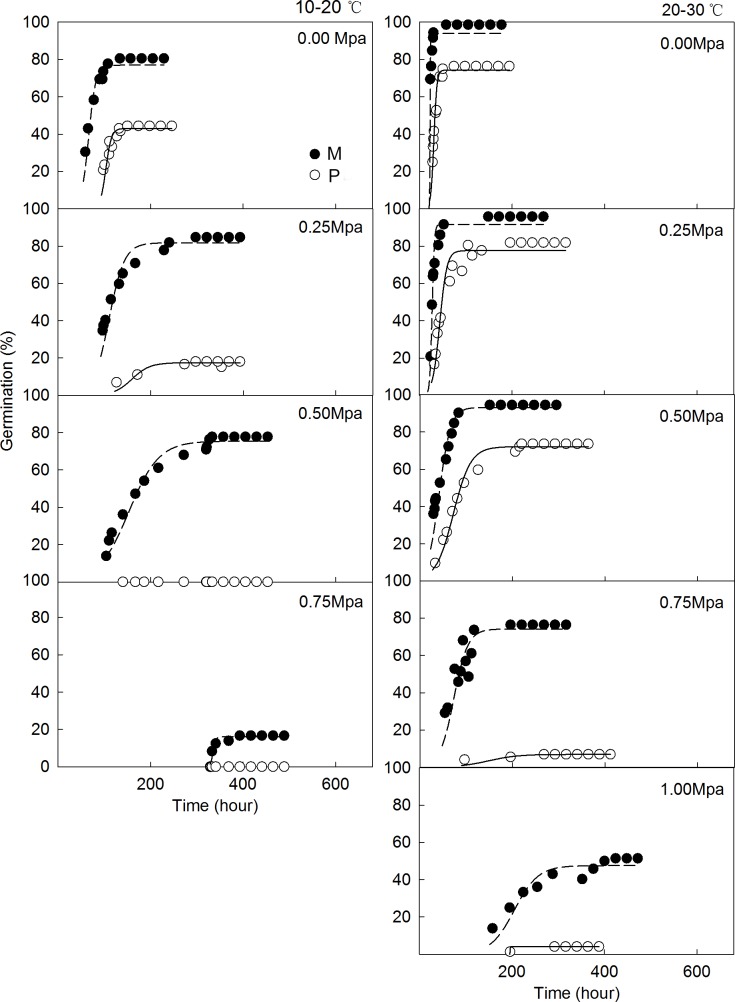
Cumulative M (solid dot) and P seeds (hollow dot) germination time-courses of C. pauciflorus under two temperatures and six osmotic potential regimes.Different symbols represent the observed germination percentages against time at different osmotic potentials. None of seeds germinated at 1.00 and 1.50Mpa at 10–20°C under 12-hour dark and 12-hour light condition.